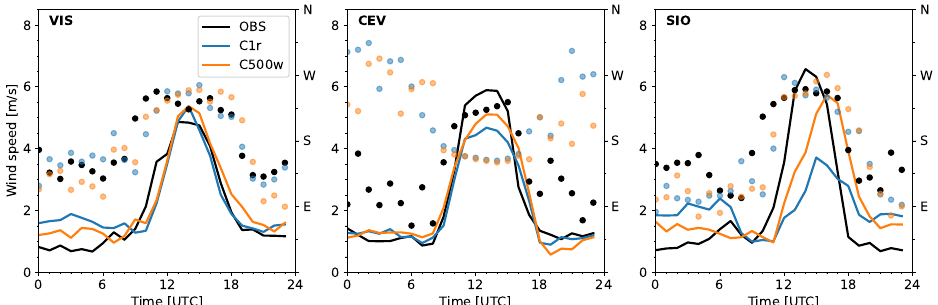
Figure 4. Mean diurnal cycle of wind speed (lines) and wind direction (symbols) for the valley wind days in September 2016 from observations and simulations for three locations: Visp (VIS), a station in a typical large valley, Cevio (CEV), a station in a typical small valley, and Sion (SIO). As indicated in Section 2.3, the mean wind speed and direction are calculated by vector averaging the hourly wind